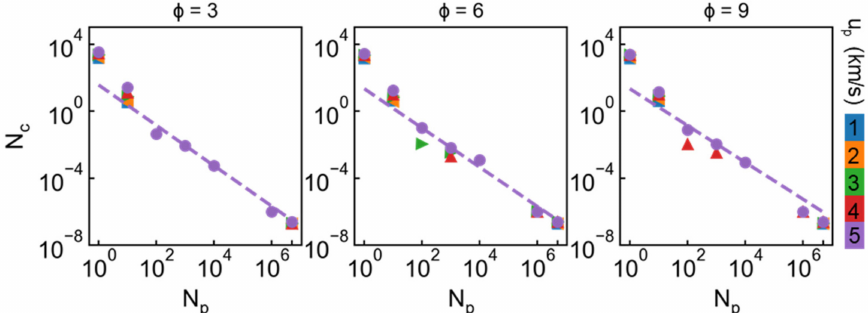
Figure 11. Number and size of cluster for incident velocity ranging from 1 to 5 km/s under different draw ratio. N p indicates the atom number in each cluster and N c means the number probability of corresponding N p range. Dash line is the power law fitting data for the case of 5 km/s, ignoring the size lower than 1000